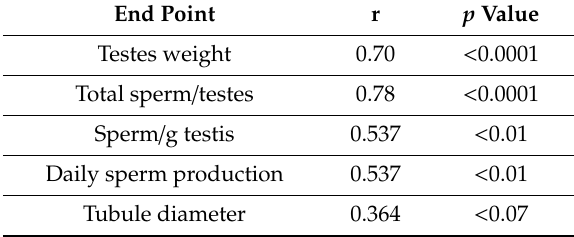
Table 2. Pearson correlations (r) between testes width and other end points in rats ( n = 32). End